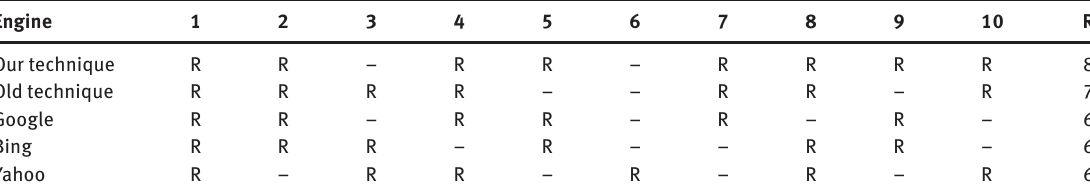
Table 2: Relevant Documents in the Top 10 Lists for the Query “Data Mining Techniques.”